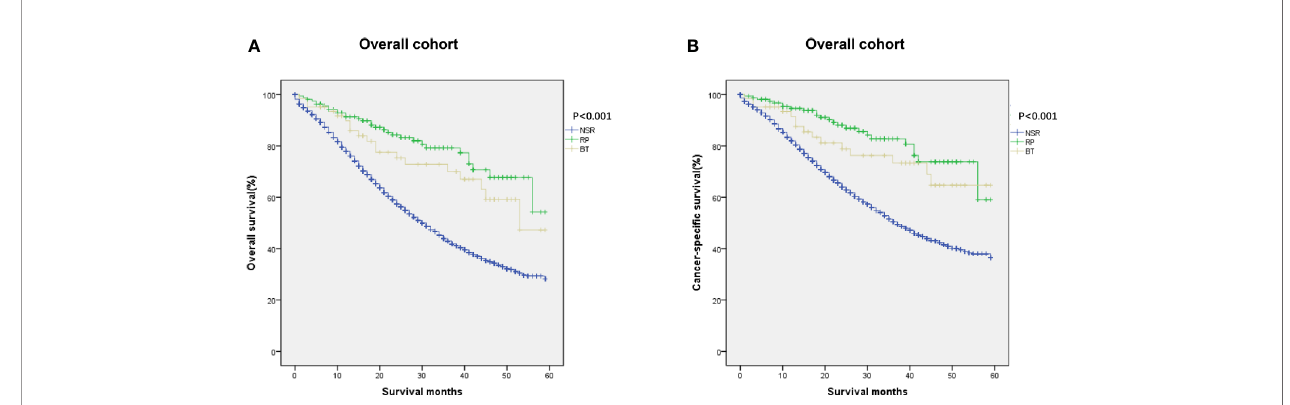
FIGURE 2 | Kaplan – Meier curves of (A) overall and (B) cancer-speci fi c survival in NSR, RP, and BT groups were performed in the overall cohort (n